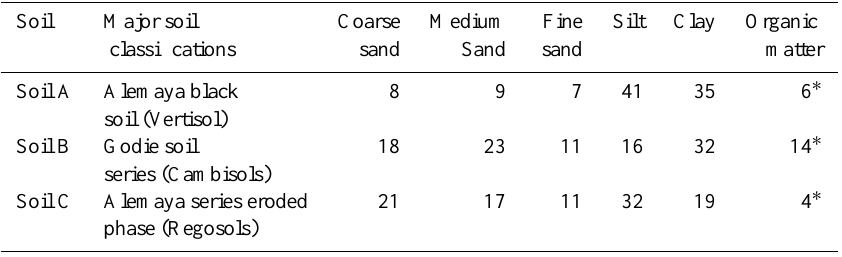
Table 2. Particle size distribution (%) of soils studied. Soil Major soil Coarse Medium Fine Silt Clay Organic classifications sand Sand sand matter Soil A Alemaya black 8 9 7 41 35 6 ∗ soil (Vertisol) Soil B Godie soil 18 23 series (Cambisols) Soil C Alemaya series eroded